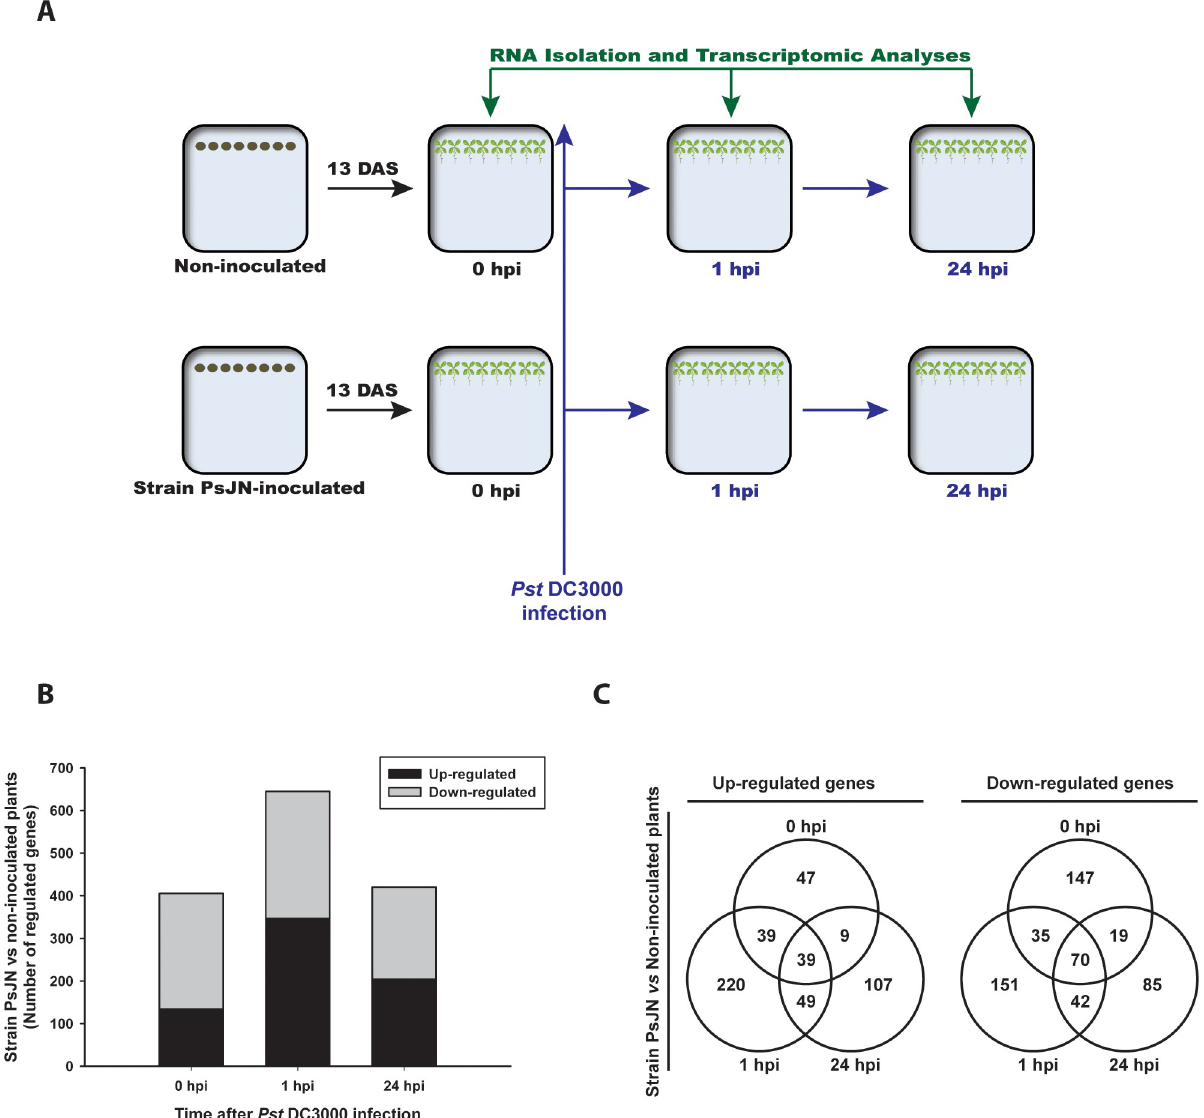
Fig 1. Transcriptomic changes induced by Paraburkholderia phytofirmans PsJN in Arabidopsis thaliana plants infected with Pseudomonas syringae DC3000. (A) Graphical explanation of the experimental design where A . thaliana seeds were inoculated (strain PsJN-inoculated) or non- inoculated at sowing, and 13 days after that (DAS) a group of plants were sampled and analyzed (0 hours post infection, hpi) and the remaining plants were infected with P . syringae pv . tomato DC3000, to collect and analyze samples at 1 and 24 hpi (B) Number of A . thaliana genes that were either up- or down-regulated by P . phytofirmans PsJN before (0 hpi) and after P . syringae DC3000 infection (1 and 24 hpi) in comparison to non-inoculated plants (Rank-product, adjusted p < 0.05) (C) Venn diagrams of the data presented in (B) showing the overlap of genes that were up- or down-regulated in Arabidopsis plants inoculated with strain PsJN before (0 hpi) and after the infection with Pst DC3000 (1 and 24 hpi).